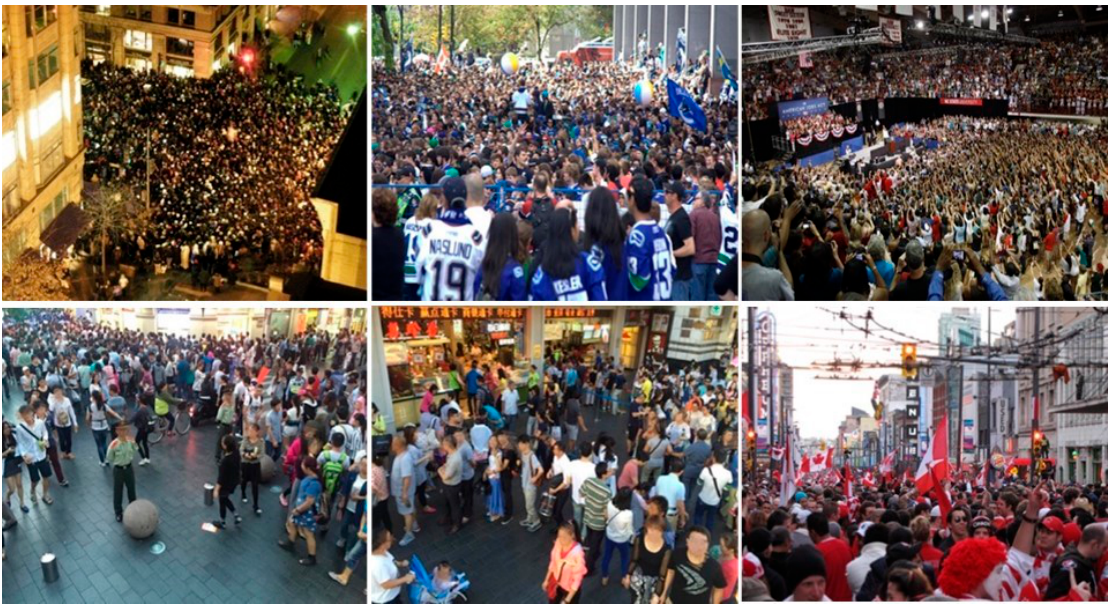
Figure 1. Examples of crowded scenes.